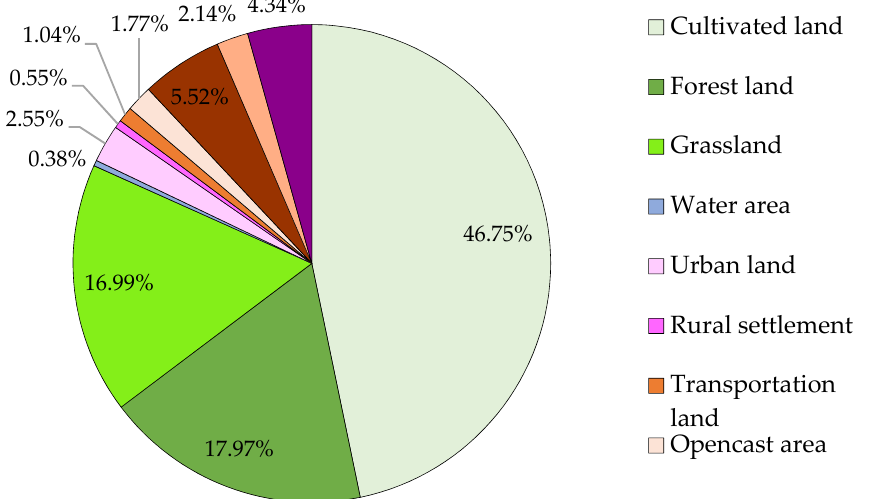
Figure 7. The areal proportion of each land-use type in the typical mine–agriculture–urban compound area. (The data were extracted from Figure 3, and the figure was made by Shufei Wang.)